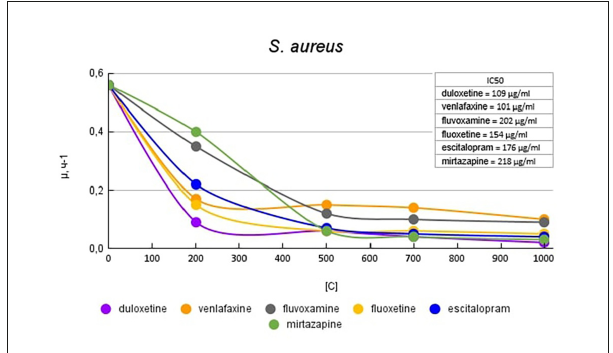
FIGURE4 Specific growth rates of E. faecalis in the presence of antidepressants.